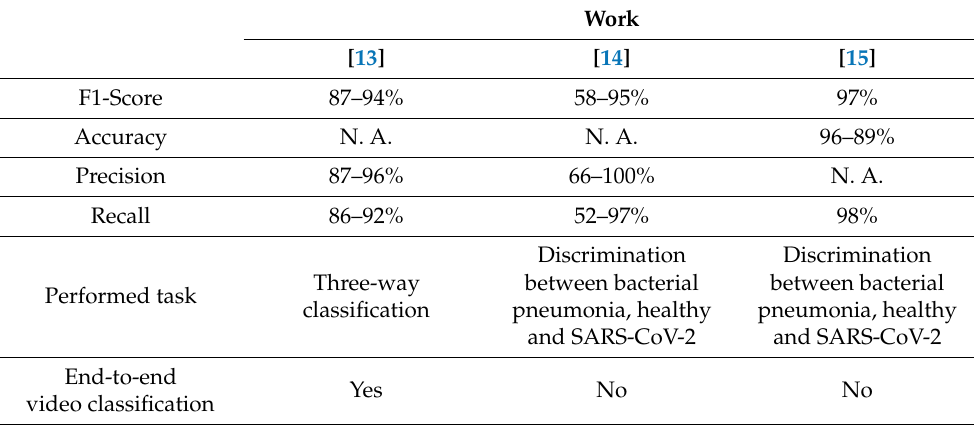
Table 8. Related works